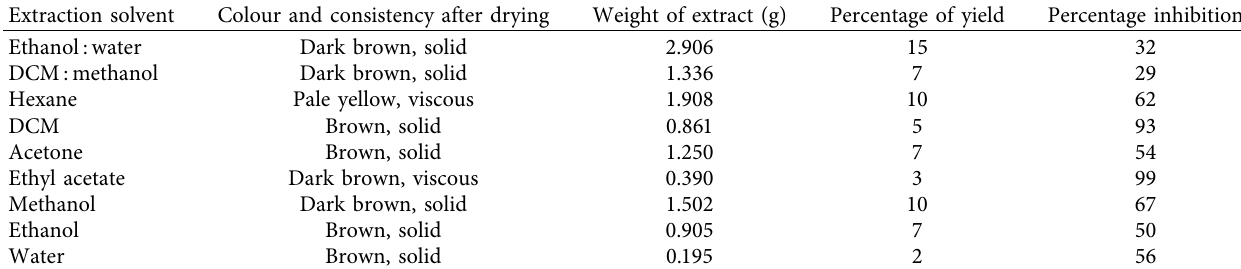
Table 1: Percentage yields and inhibitions of O. reticulata root bark